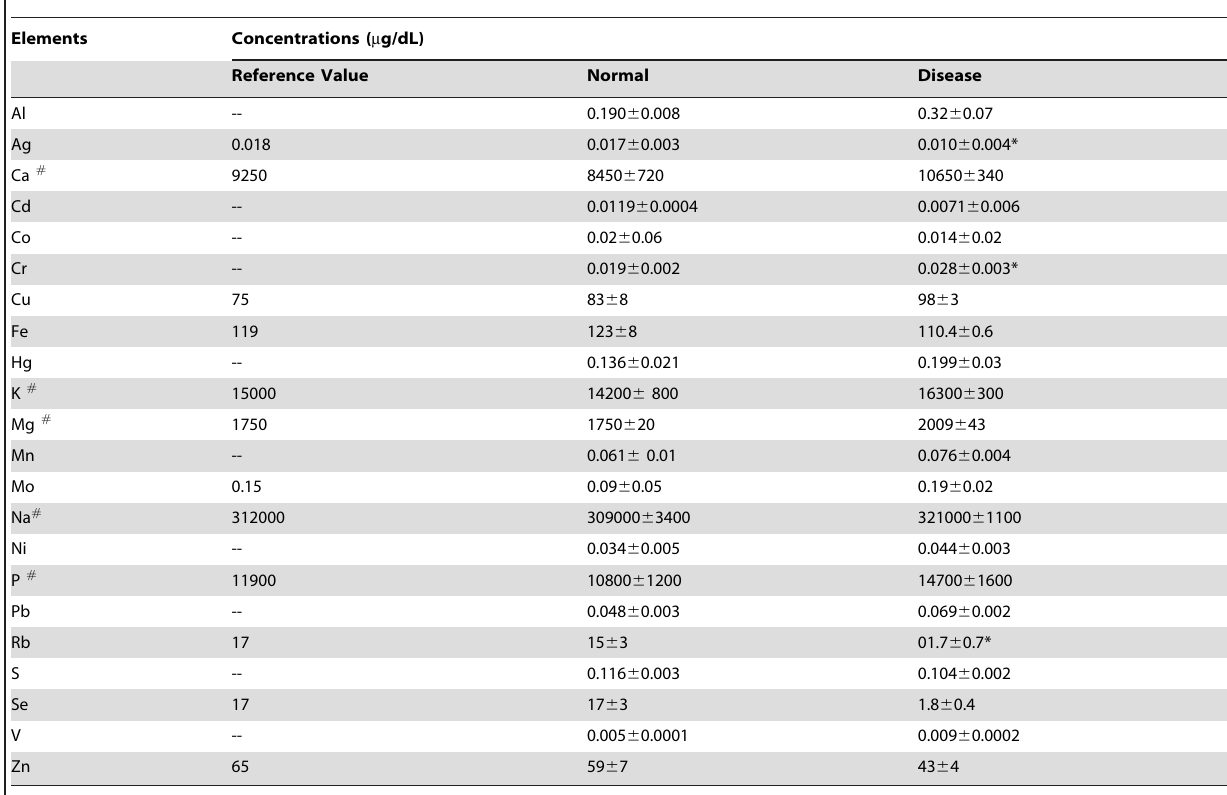
Table 1. Significant variations in element